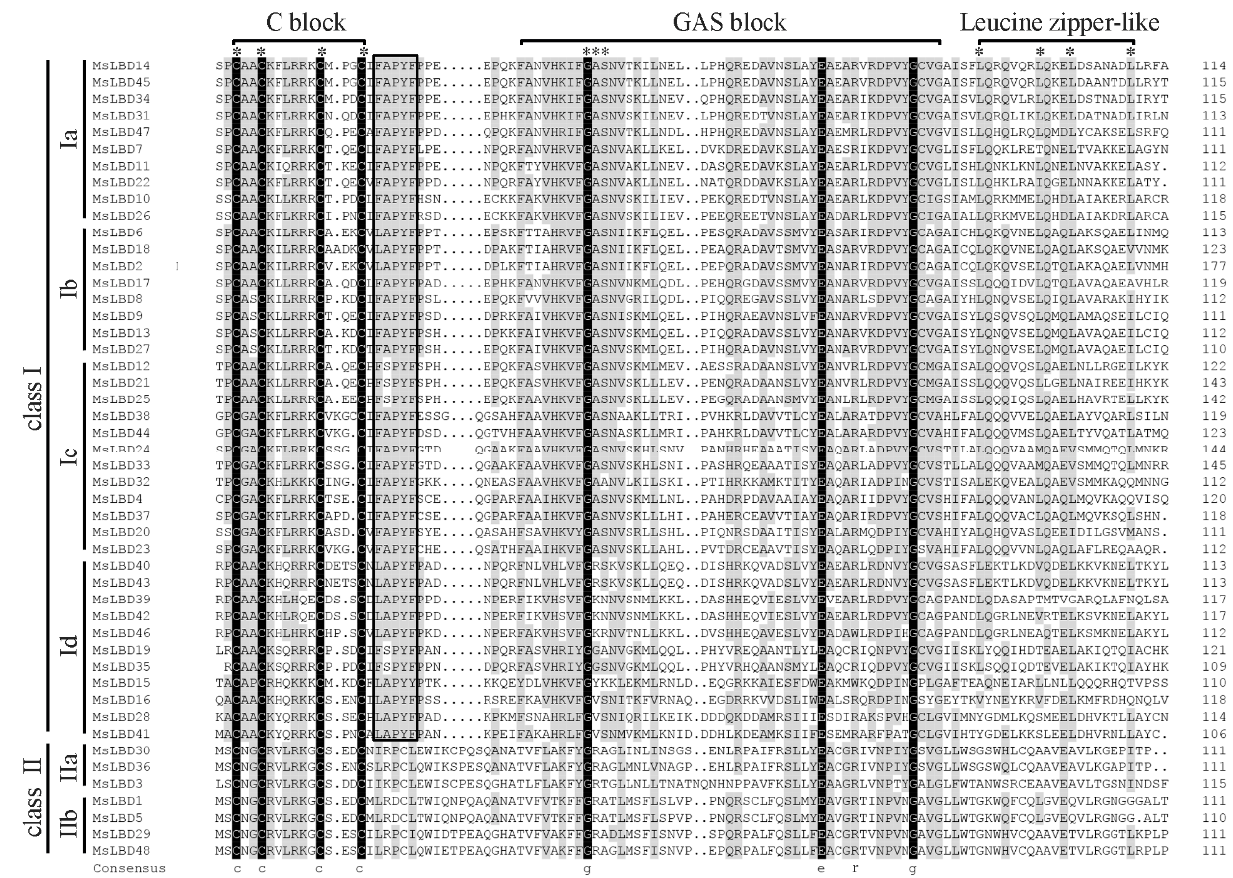
Figure 5. Alignment of the LOB domain of MsLBDs from Alfalfa . Asterisk ( ∗ ) indicated the key amino acids of LOB domain: cystine (C) of the C block; glycine (G), alanine (A) and serine (S) of the GAS block; and leucine (L) of the leucine zipper-like domain. Black box indicates (F/L)(A/S)PYF motif. Sequence identity >50% is indicated in grey, 100% in black.